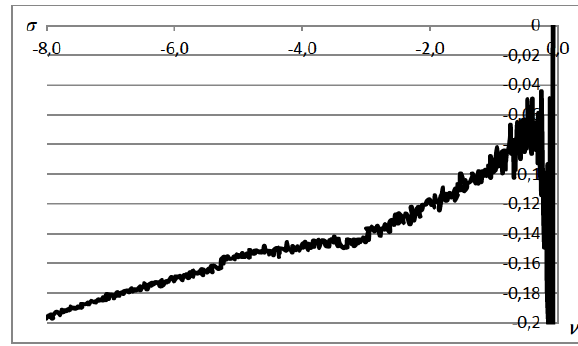
Figure 11: The dependence of the σ stress from the quotient of transverse to longitudinal deformation ν in the cement adhesive C2S2.